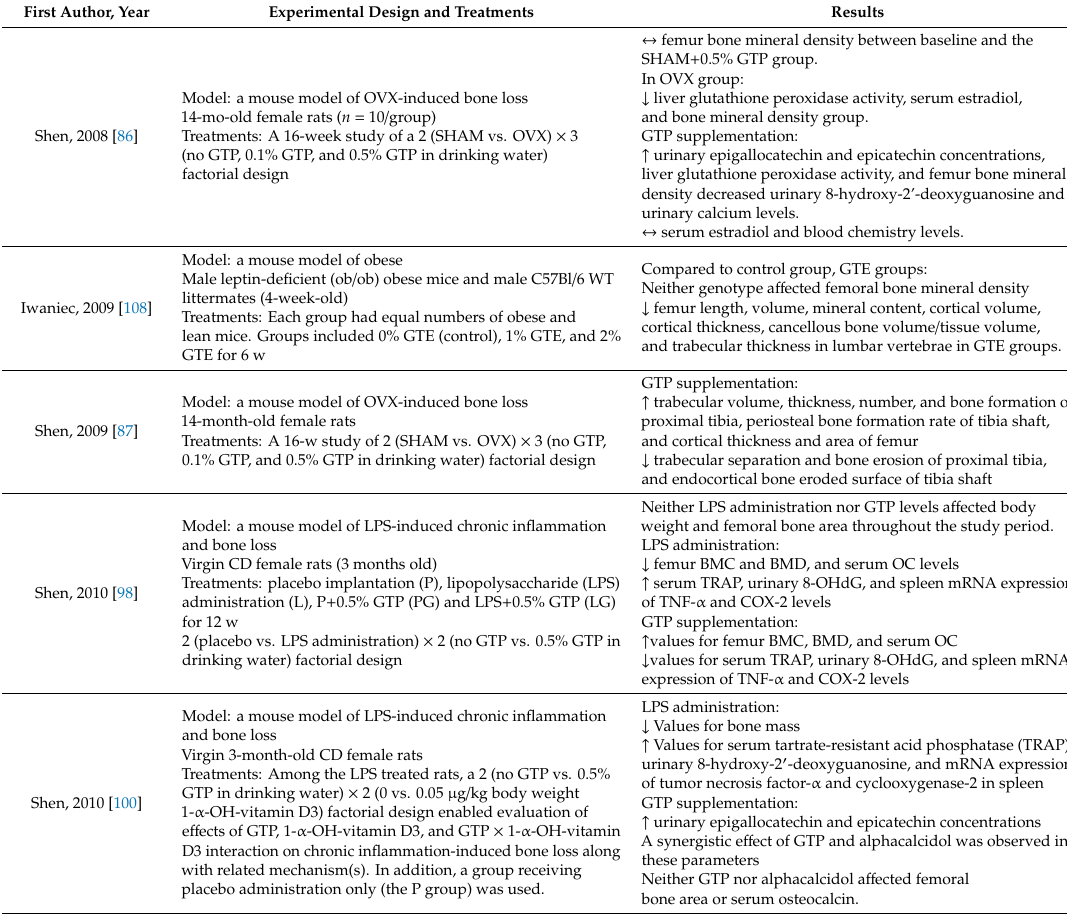
Table 2. In vivo e ff ects of